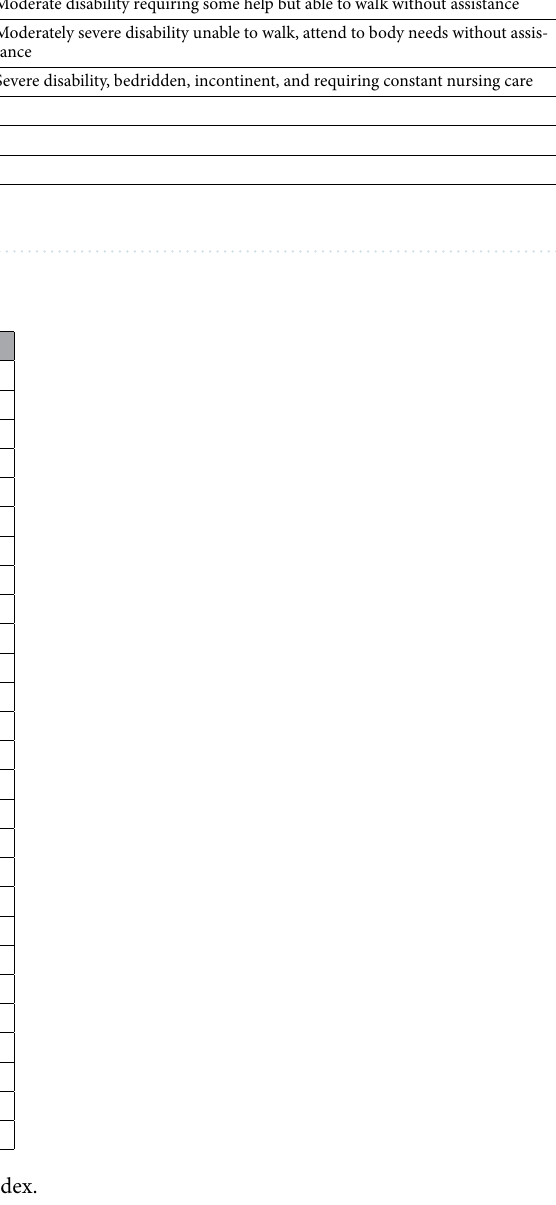
Table 2. Charlson age adjusted comorbidity